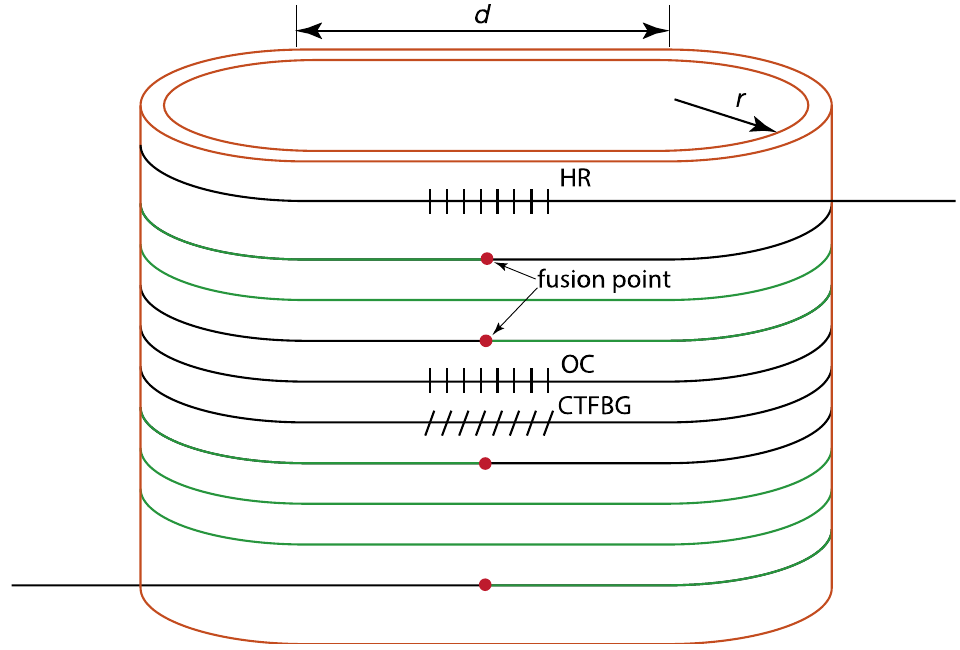
Figure 1. Schematic illustration of the oval-shaped cylinder. Red dots represent all the fusion points.